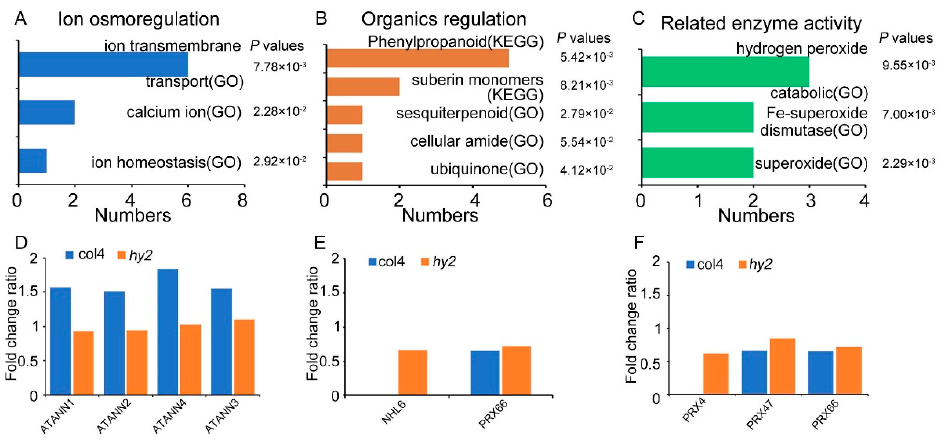
Figure 6. The important HY2-regulated salt stress pathways and the changing patterns of their key proteins in col4 and hy2 mutant. ( A , D ) Ion-osmoregulation-related pathways and the changing patterns of the key proteins ATANN1, ATANN2, ATANN3, and ATANN4. ( B , E ) Pathways related to organics regulation and the changing patterns of the key proteins NHL6 and PRX66. ( C , F ) Pathways related to enzyme activity of free-radical-scavenging system and the changing patterns of the key proteins PRX4, PRX47, and PRX66.